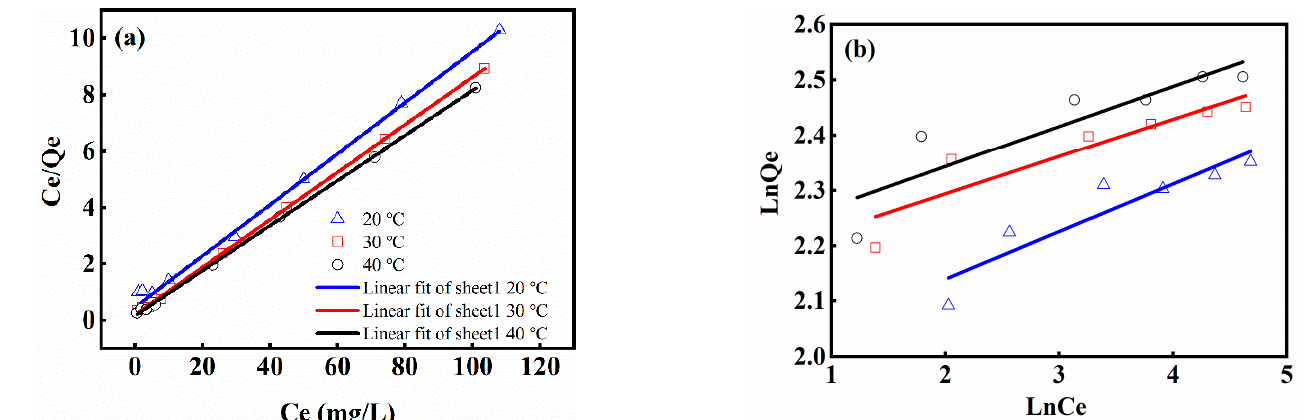
Figure 9. Pb adsorption isotherm model fitting: ( a ) Langmuir model; ( b ) Freundlich model .